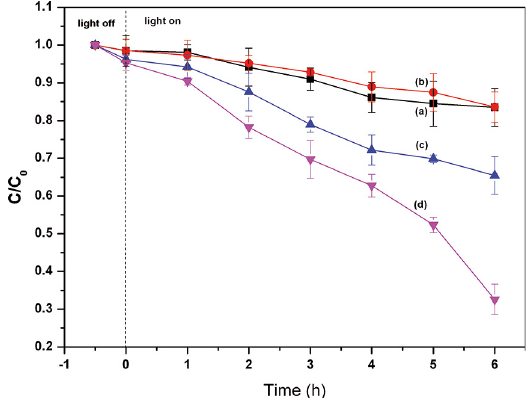
Figure 4: Photocatalytic degradation of 2,4-DCP by Cu prepared from three different types of cupric salts as raw materials under near-infrared light irradiation (a) 2,4-DCP self-decomposition; (b) Cu(CH